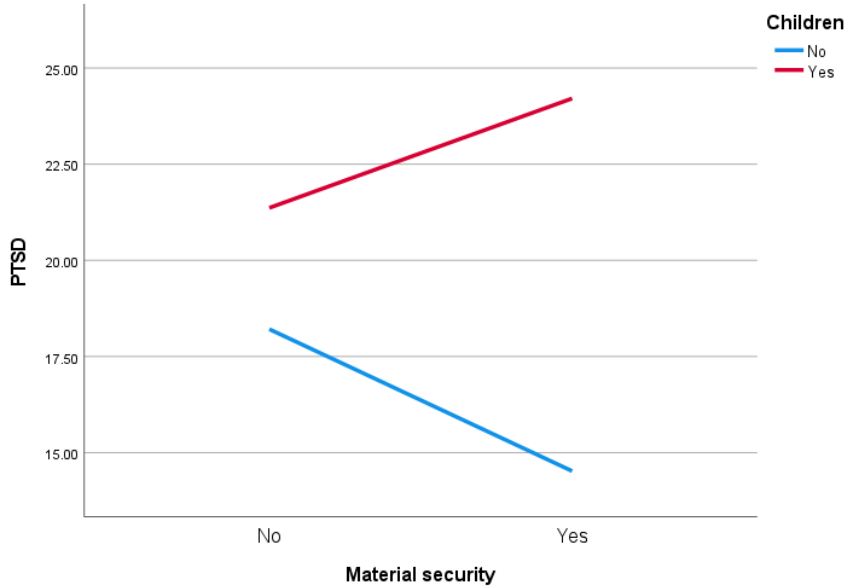
Figure 2. Effect of having children and material security on PTSD score. Table 2. Model summary for PTSD score: stepwise multiple regression analysis.